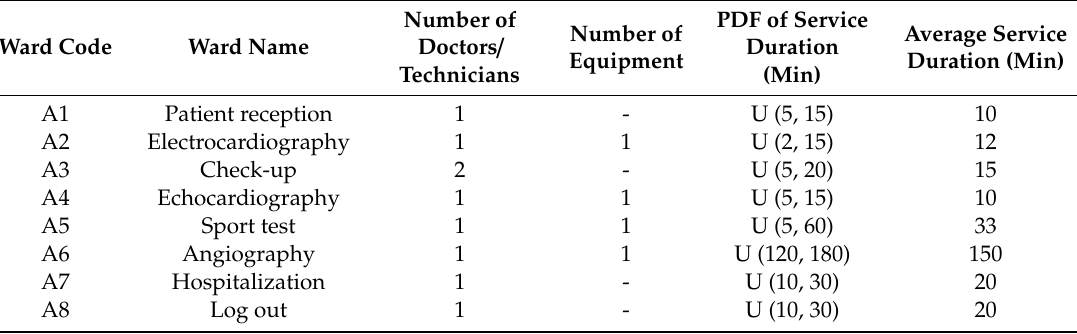
Table 2. The specifications of the wards of the heart